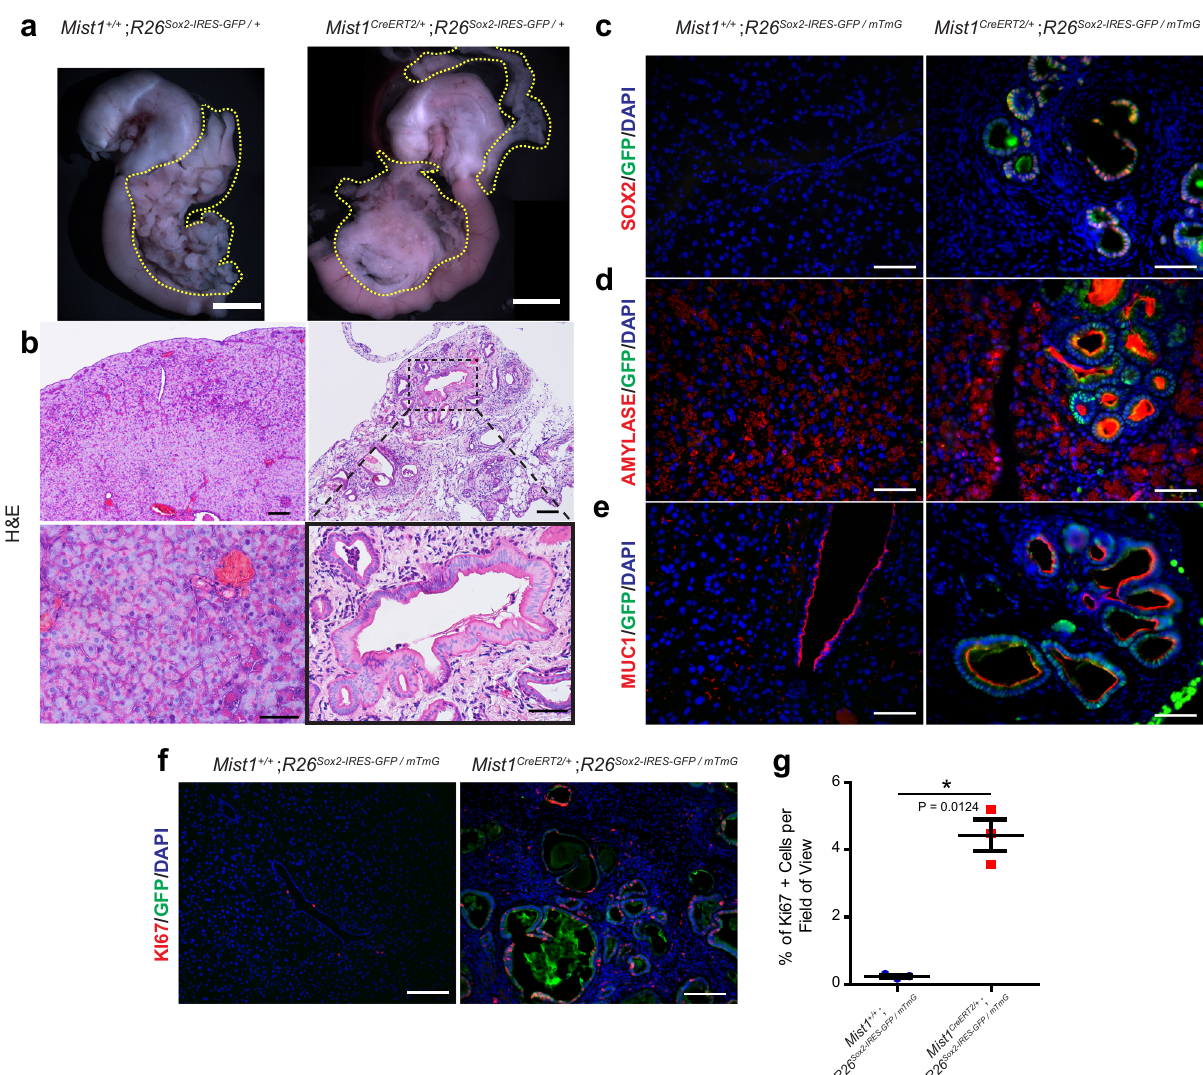
Fig. 6 Sox2 overexpression in adult pancreatic epithelial cells drives acinar-ductal metaplasia. a Whole-mount images of Mist1 + / + ; R26 Sox2-IRES-GFP/ + ( n = 3, left) and Mist1 CreERT2/ + ; R26 Sox2-IRES-GFP/ + ( n = 3, right). Scale bar = 5mm, yellow dotted lines outline the pancreas. b H&E staining of Mist1 + / + ; R26 Sox2-IRES-GFP/ + (left) and Mist1 CreERT2/ + ; R26 Sox2-IRES-GFP/ + (right) pancreas tissue. Scale bars are 100 µ m for top panels and 50 µ m for bottom panels. Black dashed box represents the magni fi ed area. Immuno fl uorescence staining of Mist1 + / + ; R26 Sox2-IRES-GFP/ + (left) and Mist1 CreERT2/ + ; R26 Sox2-IRES-GFP/ + (right) pancreas for c SOX2 (red) and GFP (green), d Amylase (red) and GFP (green), e MUC1 (red) and GFP (green), and f Ki67 (red) and GFP (green). Scale bars for ( a – f ) are 50 µ m. g Mean (±SEM) percent of Ki67 positive cells in Mist1 + / + ; R26 Sox2-IRES-GFP/ + (left, n = 3) and Mist1 CreERT2/ + ; R26 Sox2-IRES-GFP/ + (right, n = 3) pancreas tissue (* P = 0.0124, by two-sided, unpaired t -test with Welch ’ s correction). Source data are provided as a source data fi